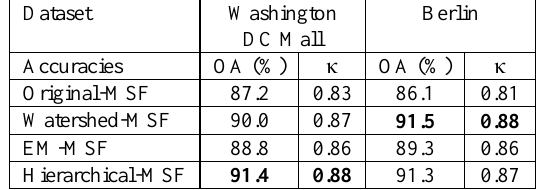
Table 2. The global accuracy values obtained for the datasets used.